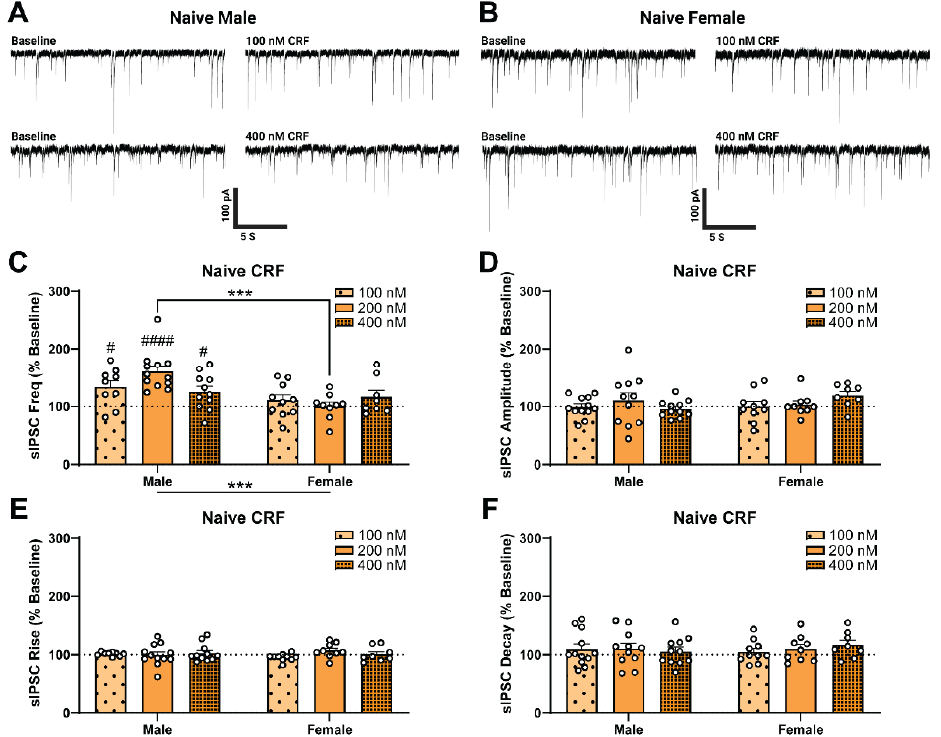
Figure 3. Spontaneous GABAergic transmission in the central amygdala (CeA) of naïve females is insensitive to corticotropin releasing factor (CRF). ( A – F ) Male and female sIPSC responses to varied concentrations of CRF. Representative GABA A -mediated sIPSCs from CeA neurons of naïve male ( A ) and female ( B ) rats at baseline ( left ) and during acute application of 100 nM CRF ( right , upper ) or 400 nM CRF ( right , lower ). ( C ) While CRF significantly increases sIPSC frequency above baseline in males, CRF has no significant effect on naïve females. In addition to a main effect of Sex, we observed a Sex × CRF Concentration interaction effect, but no main effect of CRF Concentration. There were no main effects of Sex or CRF Concentration and no interaction effect on sIPSC amplitude ( D ), rise time ( E ), or decay time ( F ). Changes from baseline sIPSC properties were assessed using one-sample t -tests where # denotes p < 0.05 and #### denotes p < 0.0001. Differences between naïve male and female sIPSC properties in response to CRF Concentrations were assessed using two-way ANOVA test with a post-hoc Šídák’s correction for multiple comparisons where *** denotes p < 0.001. Bars represent Mean ± SEM; 200 nM responses are the same as in Figure 2; n = 8–12 neurons per group; N = 4–7 rats per group.